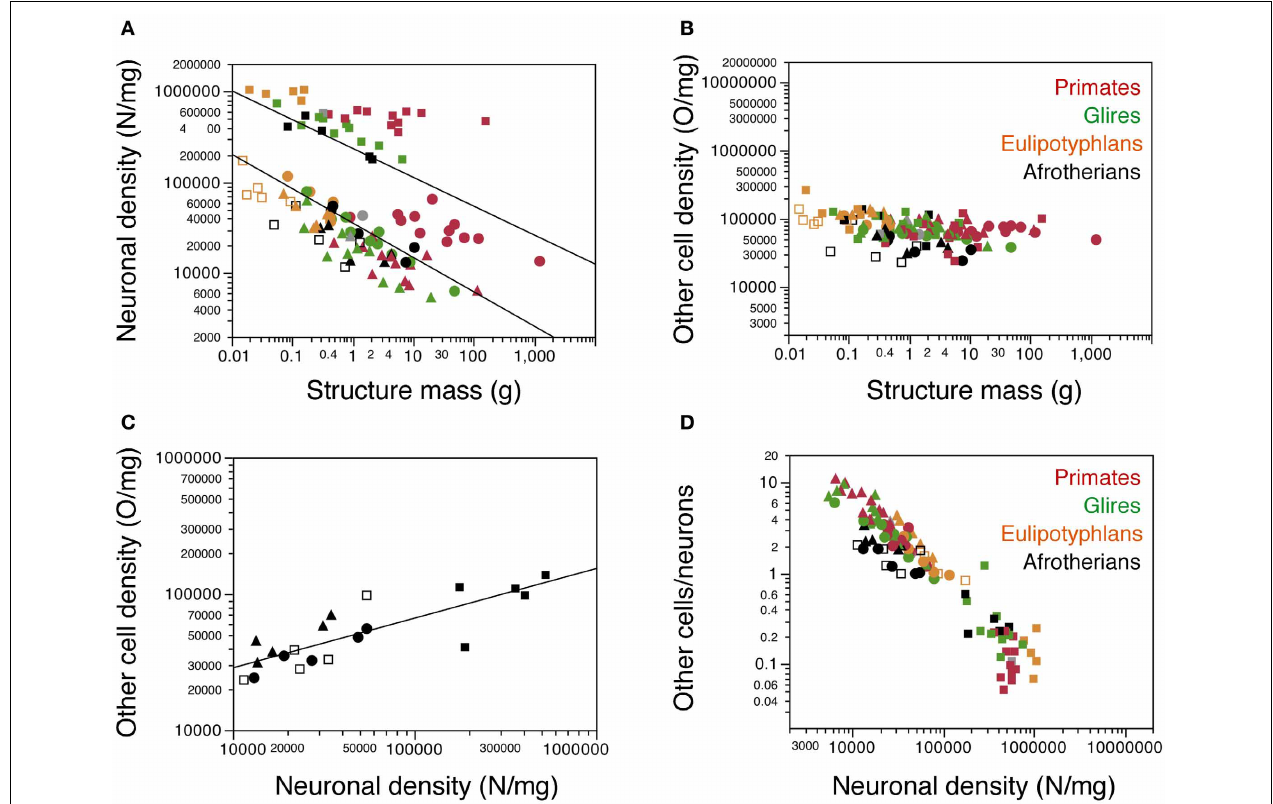
FIGURE 5 | Cellular density variation. (A, B) average neuronal density [in number of neurons per mg of tissue; (A) ] and average density of other cells [in numberofothercellspermgoftissue; (B) ]areplottedforeachstructureineach species, with a similar Y-axis for comparison. Afrotherian species are plotted in black, glires in green, primates in red, scandentia in gray, and insectivores in orange. For clarity, only the significant power functions for afrotherians are plotted in (A) (cerebral cortex with hippocampus, exponent − 0 . 378 ± 0 . 082; cerebellum, exponent − 0 . 317 ± 0 . 070). No brain structure in no mammalian order examined here exhibits a significant correlation between other cell